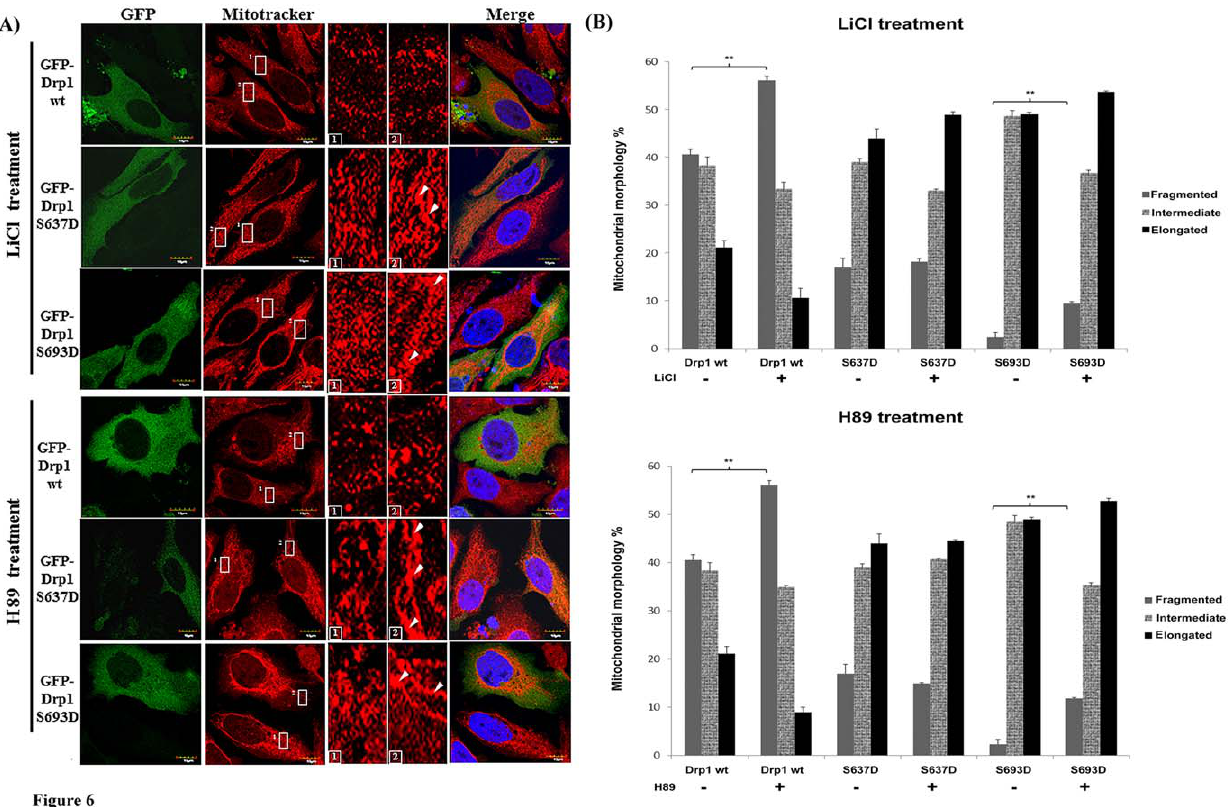
Figure 6. Mitochondrial dynamics of HeLa cells with Drp1 wt and mutants and were treated with LiCl and H89. (A) HeLa cells were transfected with GFP-tagged Drp1wt or other mutants for 24 hours. Then cells were treated with 10 mM LiCl and 10 m M H89 for another 24 hours. Mitochondrial morphology of HeLa cells was observed by staining with Mitotracker under confocal microscopy. Cell nuclei were counter-stained by using DAPI. Insets are magnifications of the Mitotracker signal at the indicated areas. Inset 1 represents the non-transfected cells, and inset 2 indicates the transfected cells. Indications (white arrows) represent typical elongated mitochondria morphology. (B) Statistical result of mitochondrial morphology. After 24 hours treated with inhibitors (upper: LiCl, lower: H89), over 100 transfected cells were categorized into 3 groups depending on mitochondrial morphology. *p , 0.05, **p , 0.01, ***p , 0.001.